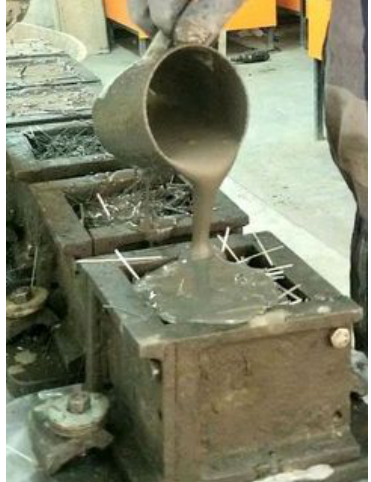
Figure 3: Casting the slurry in moulds